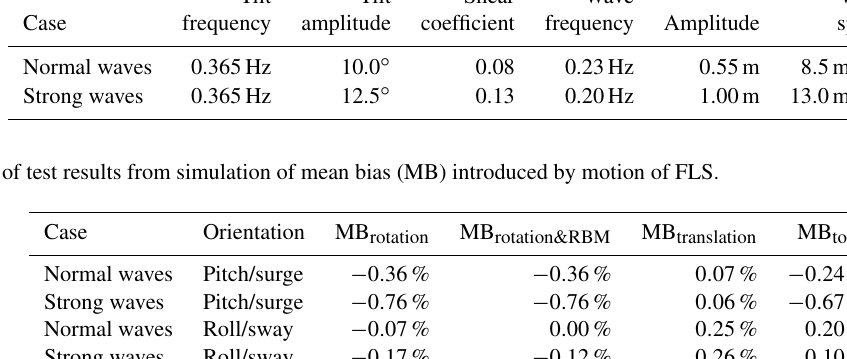
Table 1. Summary of two test cases representing typical offshore conditions. Tilt Tilt Shear Wave Wind Case frequency amplitude coefficient frequency Amplitude speed Normal waves 0.365Hz 10.0 ◦ 0.08 0.23Hz 0.55m 8.5ms − 1 Strong waves 0.365Hz 12.5 ◦ 0.13 0.20Hz 1.00m 13.0ms − 1